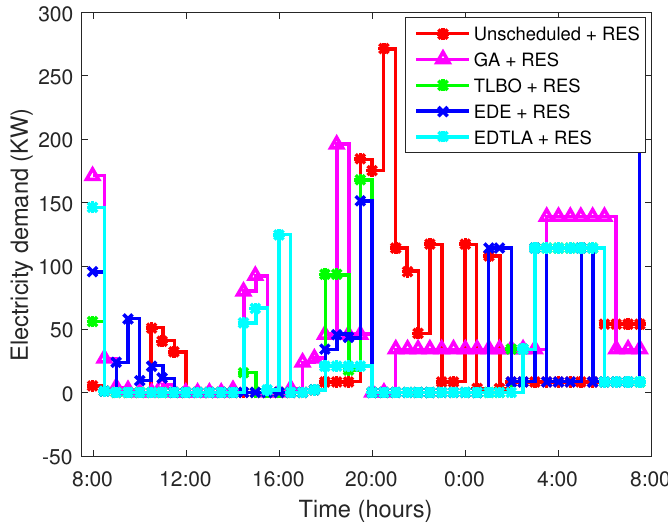
Figure 12. Hourly electricity demand with RESs and battery storage system (BSS).